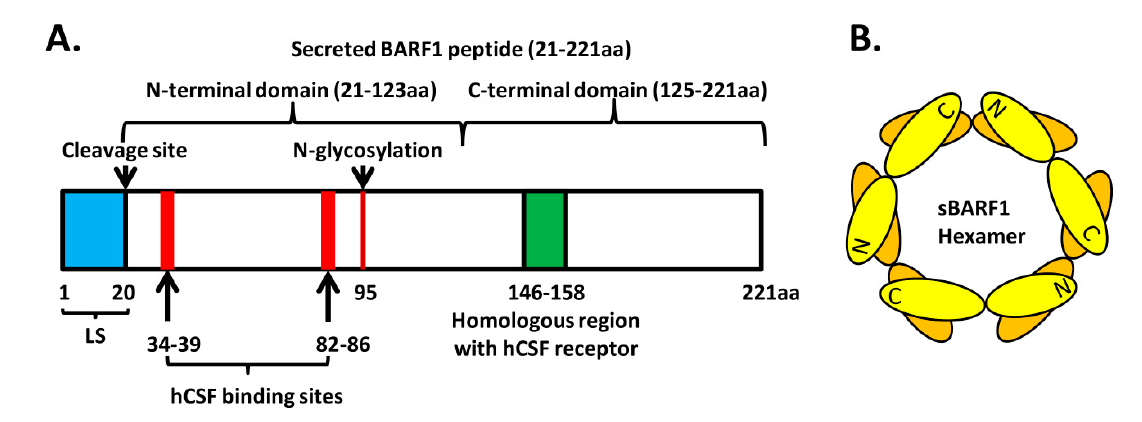
Figure 1. Schematic representation of the BamHI-A rightward frame 1 (BARF1) protein: ( A ) A diagram showing the positions of the leader sequence (LS), cleavage site, N-linked glycosylation site, human colony-stimulating factor (hCSF) binding sites and the homologous region with an hCSF receptor. ( B ) The soluble BARF1 hexameric structure: It is composed of three dimer BARF1 molecules which are interconnected N-terminal domain (head) to C-terminal domain (tail) and are arranged in two layers.